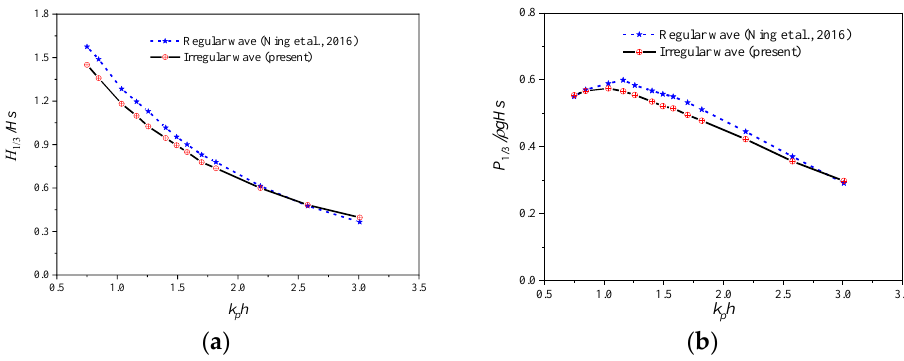
Figure 9. Comparison of ( a ) significant wave heights at the chamber mid-point and ( b ) significant pneumatic pressures in the chamber versus k p h between regular and irregular wave conditions.